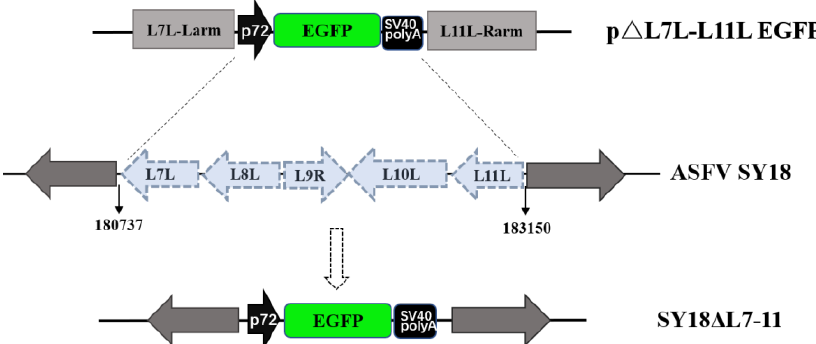
Figure 1. Schematic of recombinant virus construction. The L7L-L11L fragment of African swine fever virus (ASFV) SY18, including the open reading frames (ORFs) of L7L–L11L and the intergenic regions, was replaced by an expression cassette as shown.